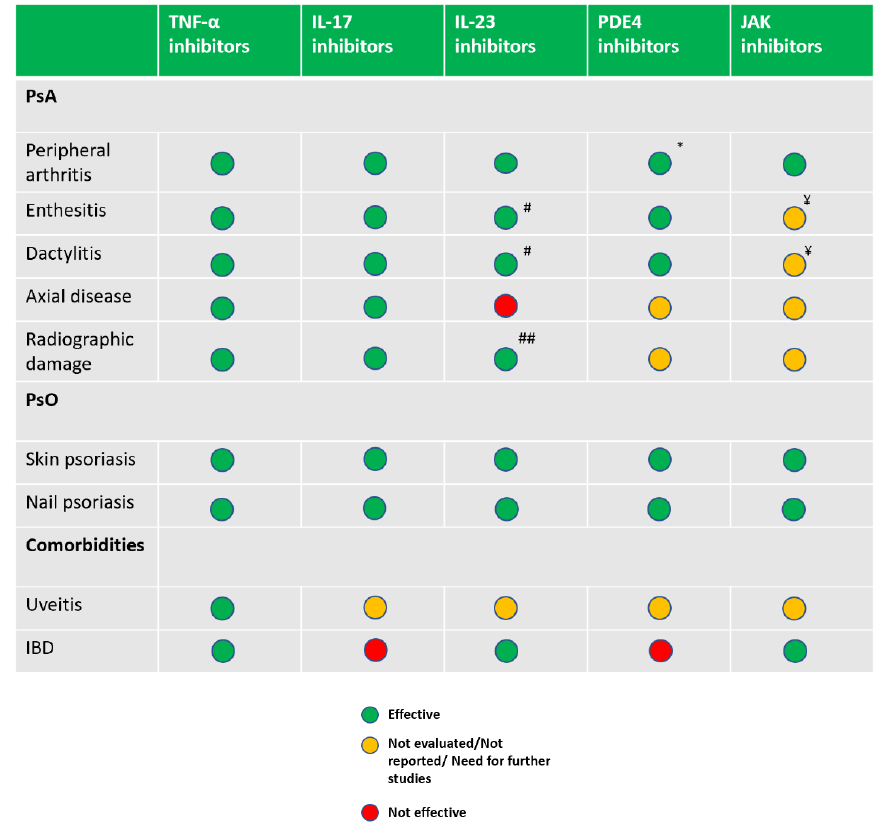
Figure 4. E ffi cacy of recently introduced therapeutic principles for PsA based on randomised controlled Figure 4. Efficacy of recently introduced therapeutic principles for PsA based on randomised trials stratified for disease domain. # Risankizumab, no significant di ff erence versus placebo in controlled trials stratified for disease domain. # Risankizumab, no significant difference versus improving dactylitis and enthesitis [66]. ## Ustekinumab, an anti-IL 12 / 23 p40 monoclonal antibody, placebo in improving dactylitis and enthesitis [66]. ## Ustekinumab, an anti-IL 12/23 p40 monoclonal inhibits radiographic progression in patients with active PsA [67]. Guselkumab, an anti-IL23